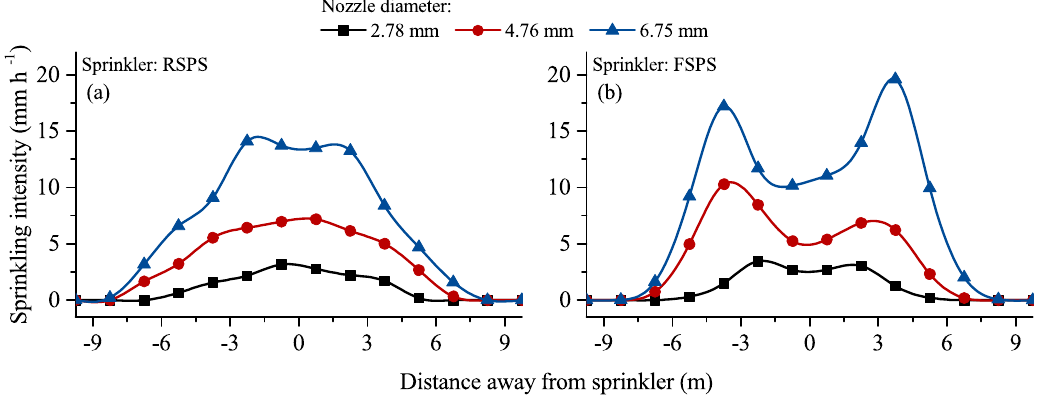
Figure 6. Application intensity in radii of individual rotating spray plate sprinklers (RSPSs) ( a ), and fixed spray plate sprinklers (FSPSs) ( b ).